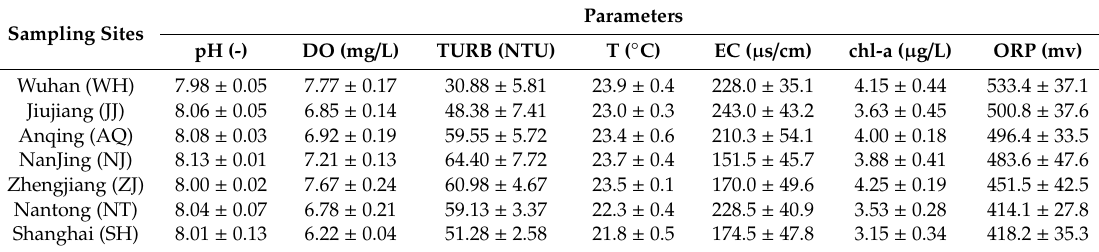
Table 1. Water physicochemical parameters of the main urban river stretches along the middle and lower reaches of Yangtze